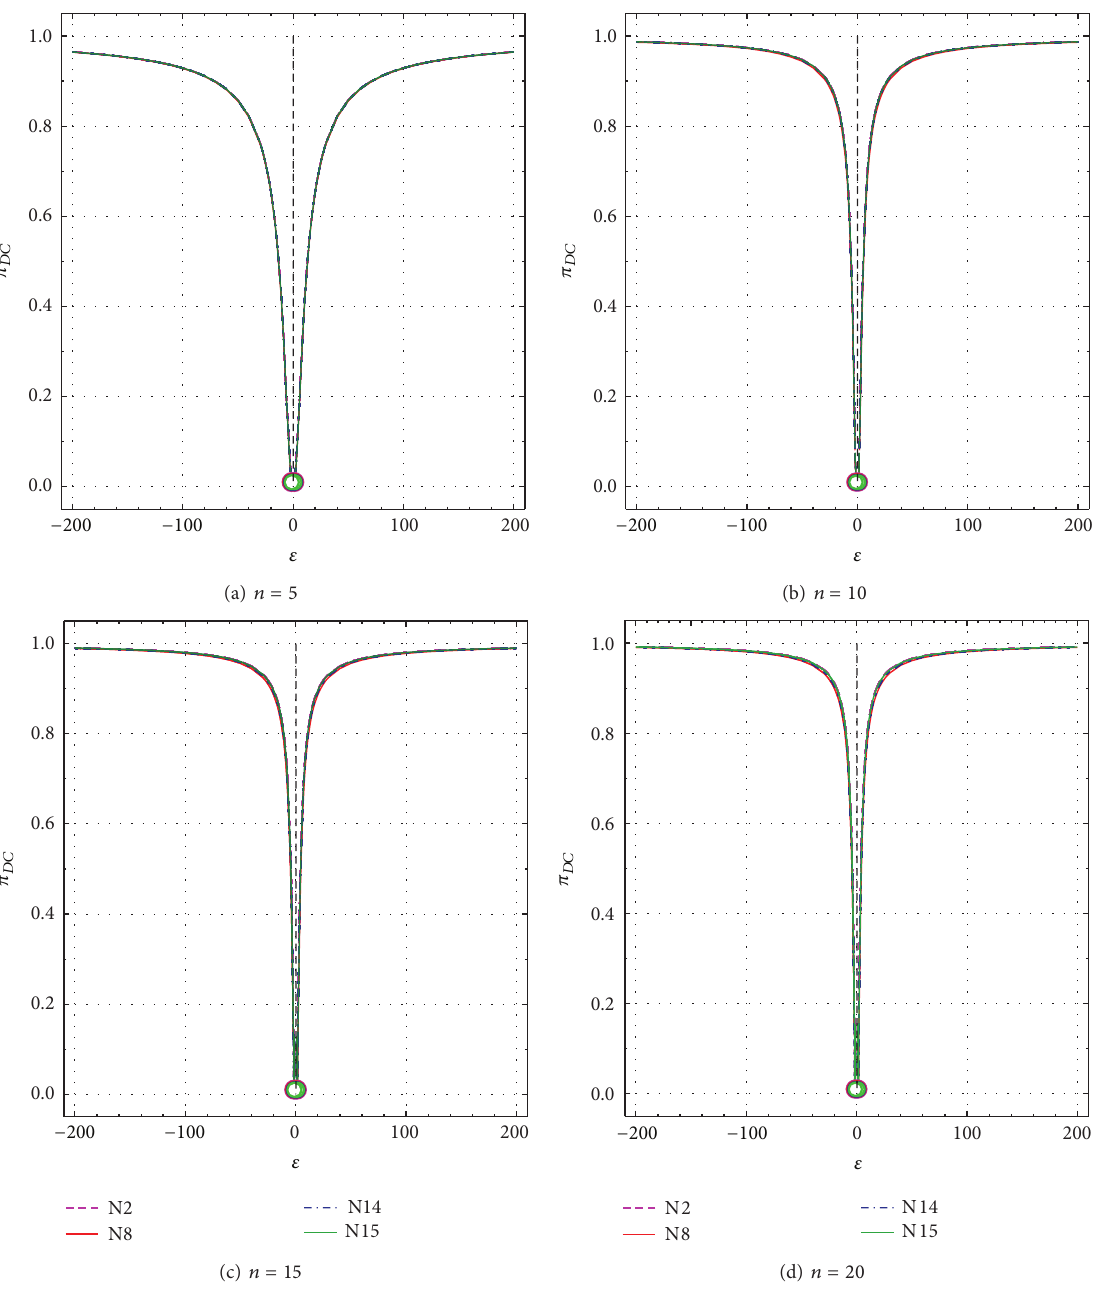
Figure 8: Nonspurious power probability ( 𝜋 𝐷𝐶 ) as a function of 𝜀 from − 1 to − 200 and +1 to +200 for all tests N2, N8, N14, and N15. 𝜋 𝐷𝐶 values for uncontaminated samples ( 𝜀 = ±1 ) are shown by open circles. (a) 𝑛 = 5 ; (b) 𝑛 = 10 ; (c) 𝑛 = 15 ; and (d) 𝑛 = 20 .